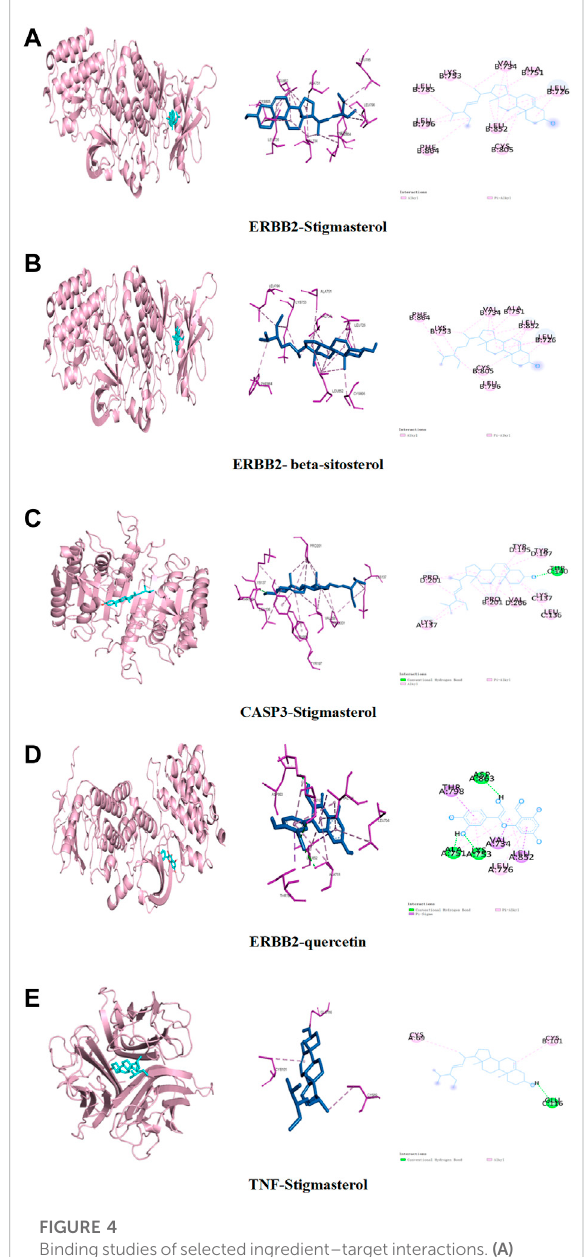
FIGURE 4 Bindingstudiesofselectedingredient – targetinteractions. (A) ERBB2 with stigmasterol; (B) ERBB2 with beta-sitosterol; (C) caspase-3 with stigmasterol; (D) TNF with stigmasterol; (E) ERBB2 with